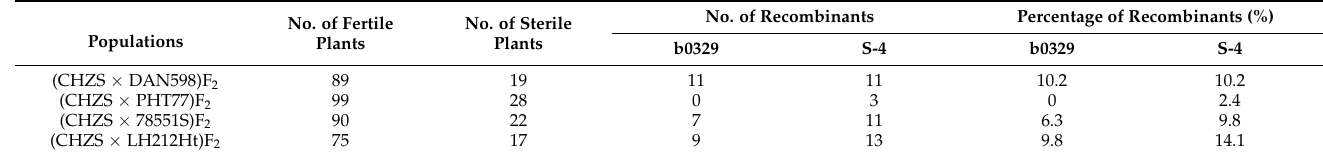
Table 6. The segregation of fertility in BC 1 populations derived from the cross between the CHZS, A619, and tester lines.